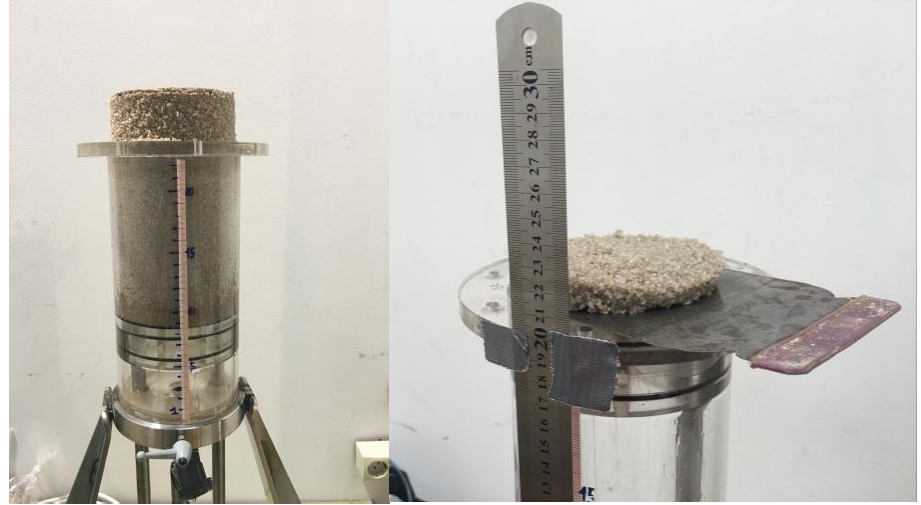
Figure 3. Extraction of bed slices in the experimental filter.